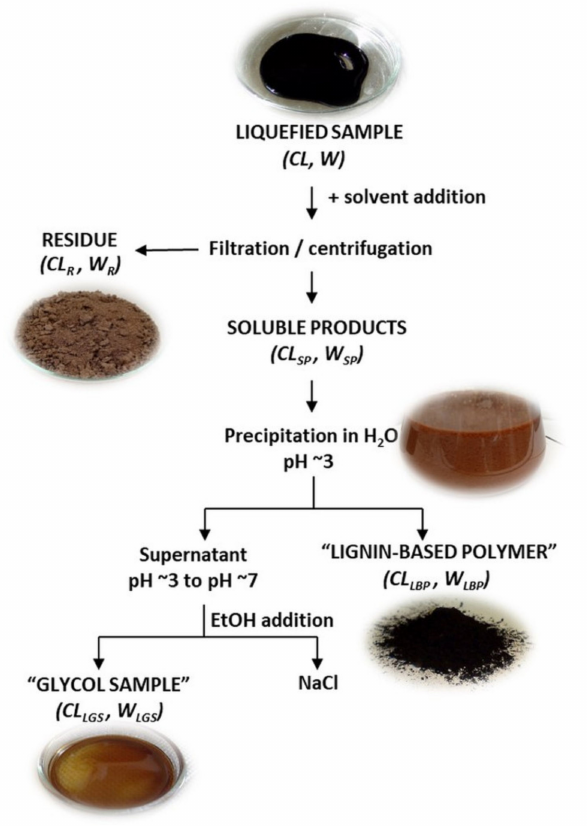
Scheme 1. Sample preparation procedure with real samples